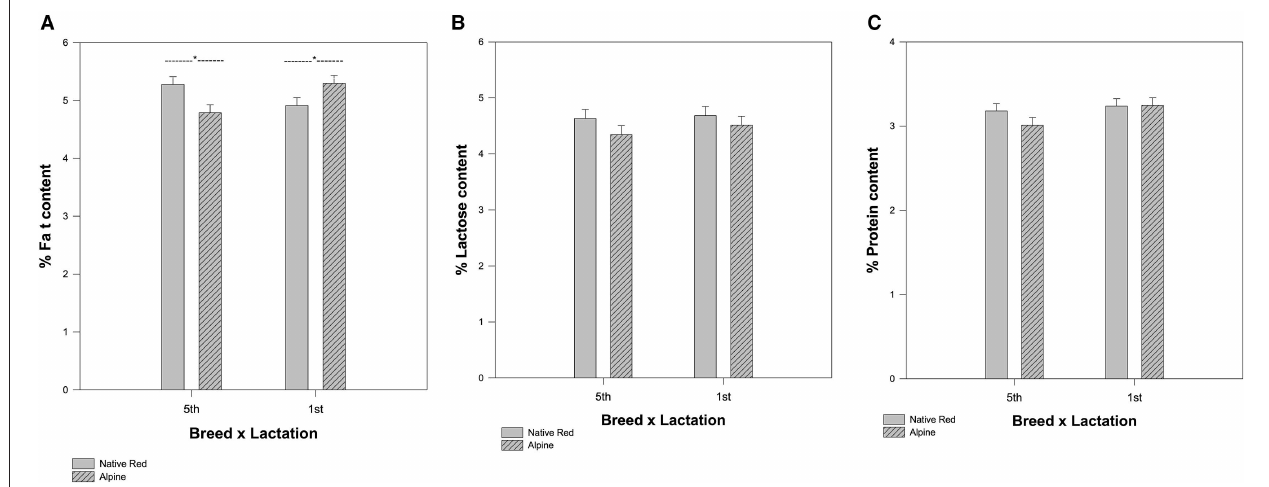
FIGURE 2 | The difference in mean values among the breeds depending on lactation season for (A) fat, (B) lactose, and (C) protein content. The interaction between breed and lactation is significant for fat (* p = 0.002), but not for lactose ( p = 0.716) and protein ( p = 0.328).